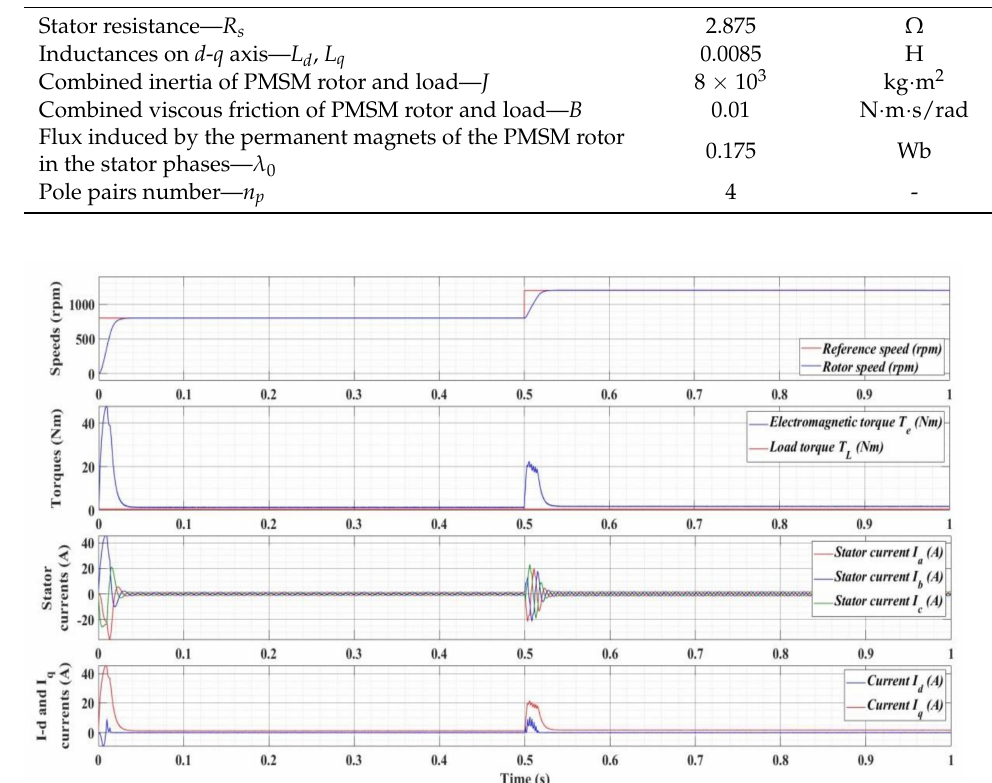
Figure 28. Time evolution for the numerical simulation of the PMSM control system based on the FOC-type